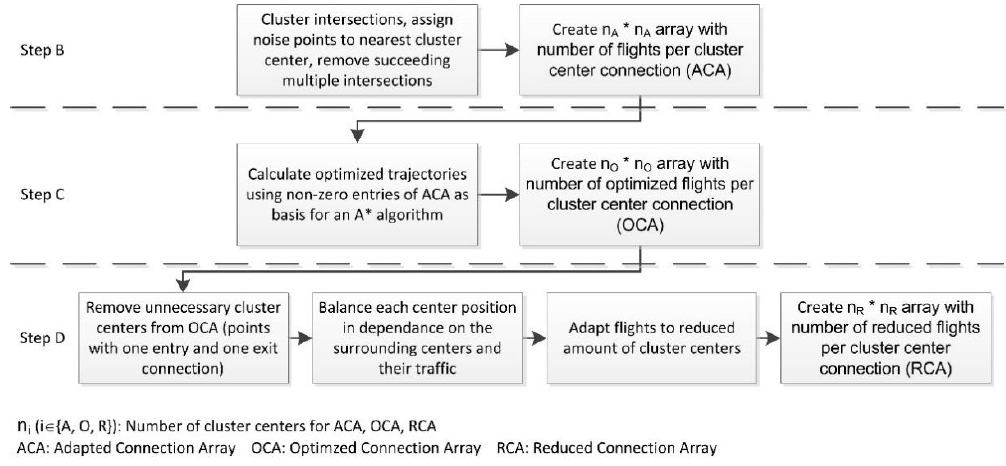
Figure 3. Main-flow processing (steps B to D).